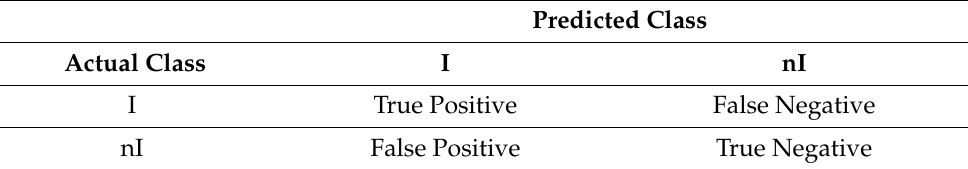
Table 4. Example of a confusion matrix. I = improved; nI =